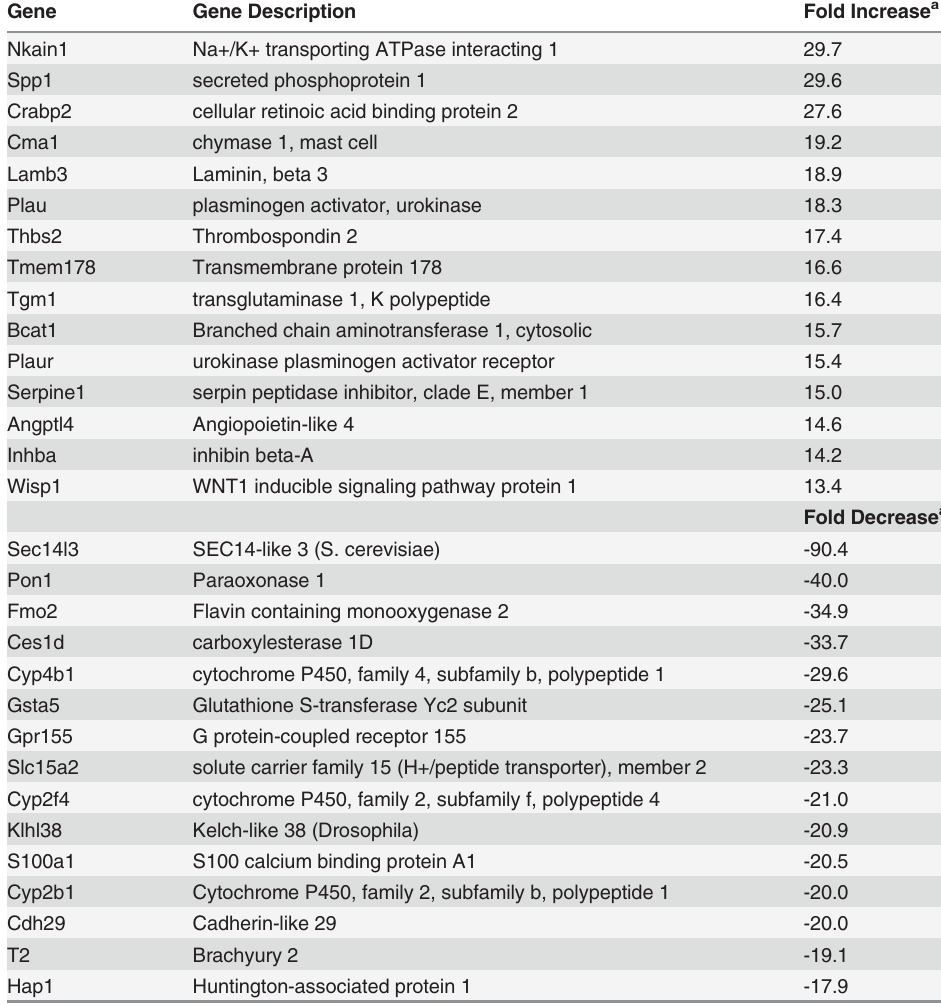
Table 2. Fibrotic Bronchi: Major Changes in Gene Expression.